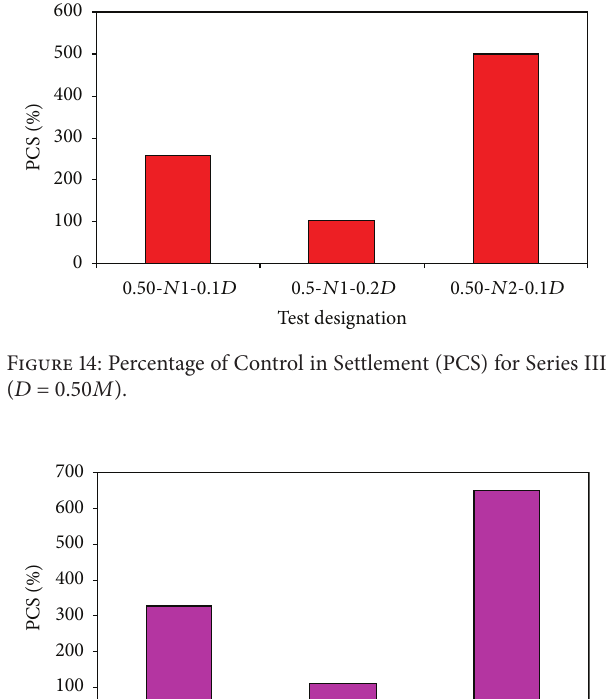
Figure 13: Load-settlement curve for Series III ( 𝐷 = 0.75 𝑀 ), comparison.